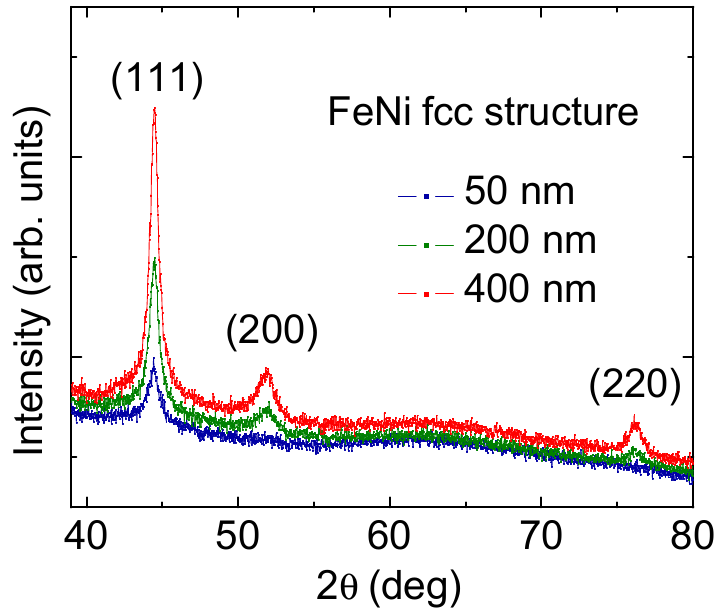
Figure 1. X-ray diffraction patterns for FeNi films with different thicknesses indicated in the legends. Miller indexes are shown for all bright peaks.